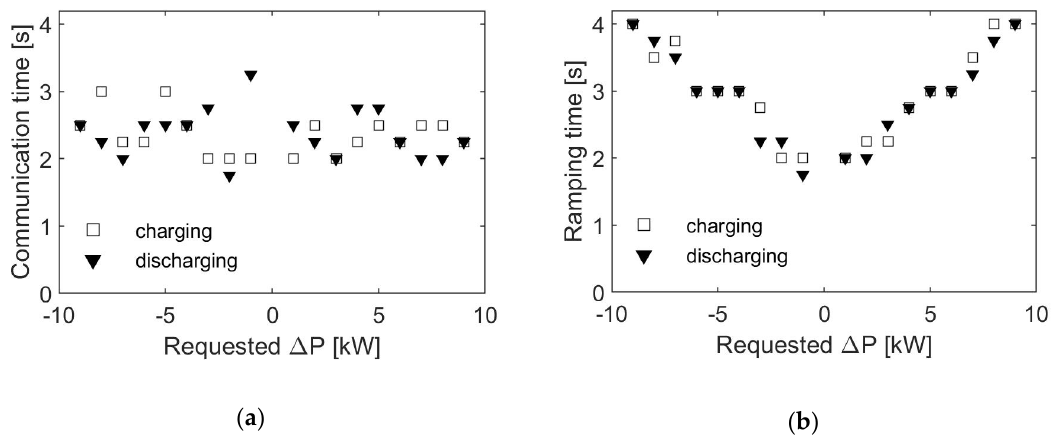
Figure 6. ( a ) Communication time; ( b ) and ramping time as a function of the requested power ramp ( ∆ P) for charging (squares) and discharging (filled triangles) modes. Only the ramping time appeared to depend (linearly) on the requested ramping. Each value represents the average of four identical tests, with a standard deviation ranging ± 0.5 and ± 1 s.